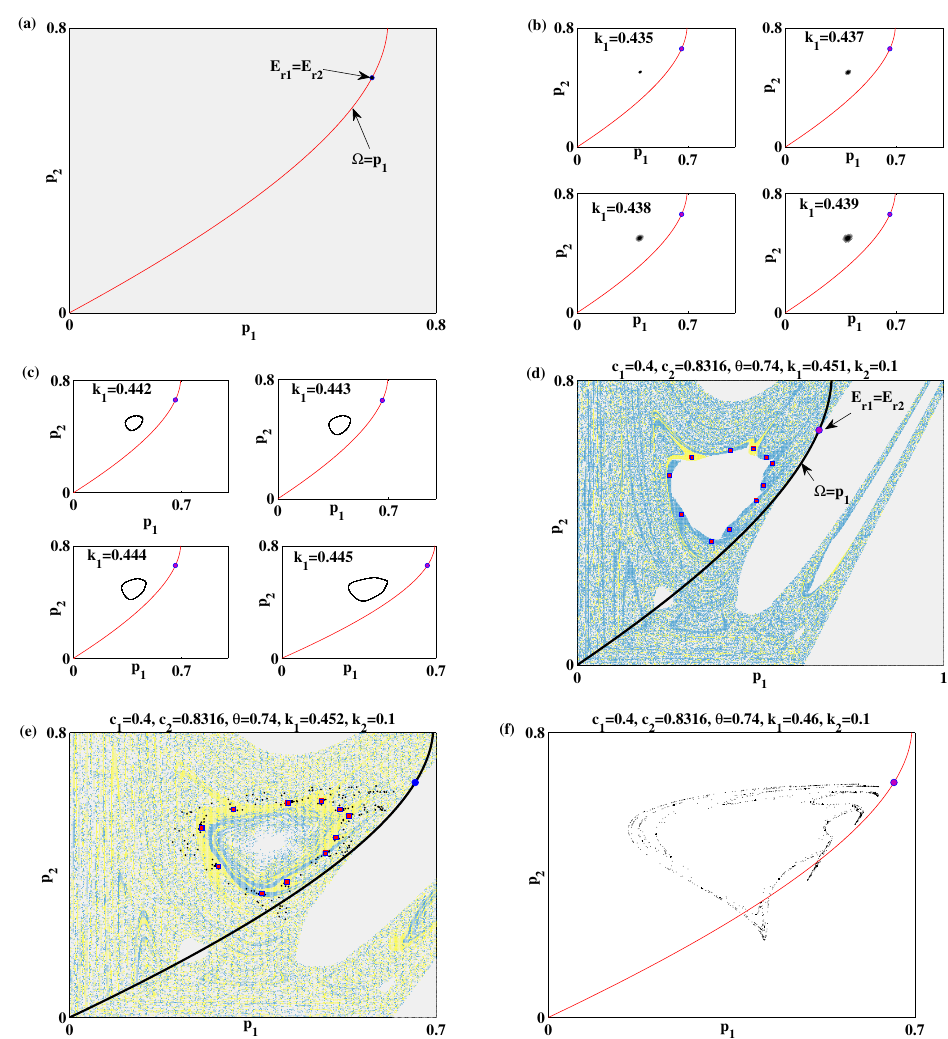
Figure 4. ( a ) The stable equilibrium point with its basin of attraction around it. Parameters values are c 1 = 0.4, c 2 = 0.8316, θ = 0.74, k 1 = 0.1 and k 2 = 0.1. ( b ) Spiral points at different values of k 1 . ( c ) Closed invariant curves at different values of k 1 . ( d ) The basin of attraction for the period-11 cycle at k 1 = 0.451. The gray color denotes divergent and infeasible trajectories. ( e ) Basin of attraction of the period-11 cycle with the chaotic attractor. ( f ) Phase plane of the chaotic